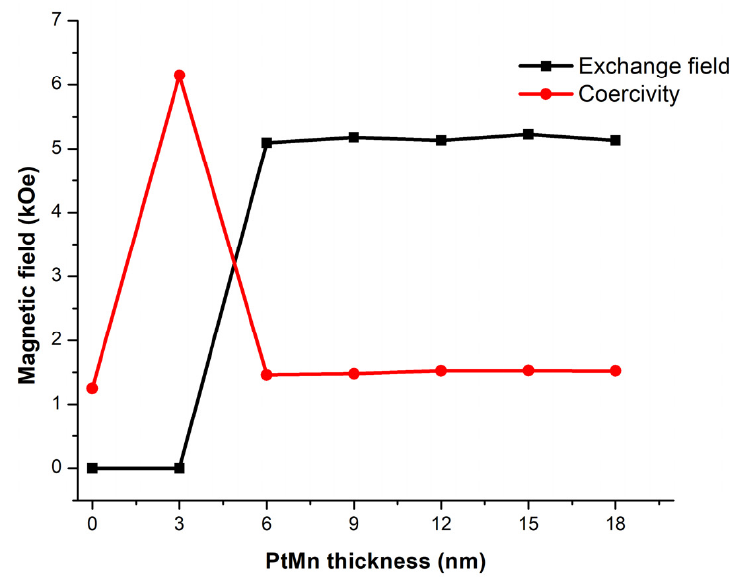
Figure 9. The plot of the exchange field and coercivity field of Terfenol–D coupling with PtMn at the PtMn thickness of 0–18 nm.